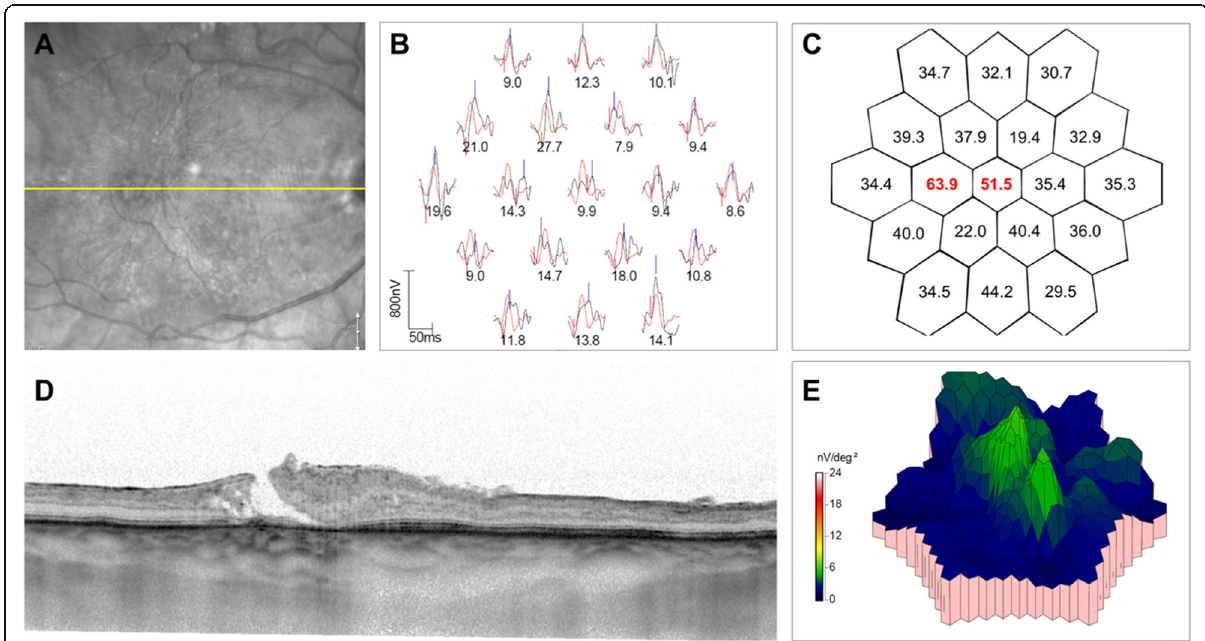
Fig. 3 Correlation between the spectral-domain optical coherence tomography (SD-OCT) line scans and multifocal electroretinography (mfERG) of a patient with birdshot chorioretinopathy ( a – d ). The area through which the line scan passes is shown in the infrared image in a . The OCT line scan ( d ) shows disruption of the inner and outer retinal layers at an area temporal to the foveal center. The mfERG trace arrays show abnormal waveforms at the retinotopically correlated points represented by the area of tissue disruption on OCT ( b ). In addition, the numeric values below the abnormal waveforms show reduced amplitude density at these areas of interest. The hexagons in ( c ) (2D topography maps) depict the implicit times at each of the tested areas. In the area of SD-OCT retinal layer disruption, there are increased implicit times noted in red. The color map also shows blunted mfERG response ( e )